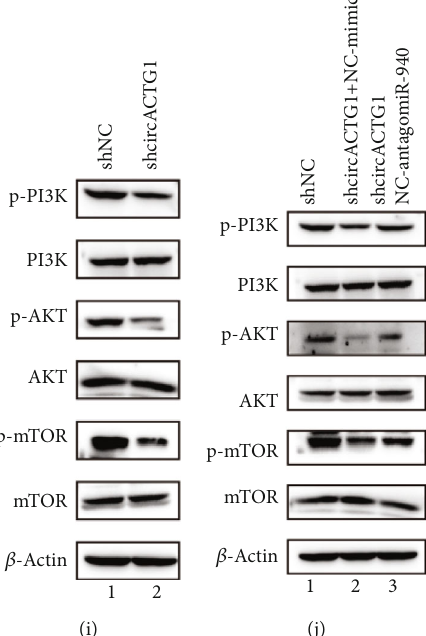
Figure 5: The AKT-mTOR pathway was activated by circACTG1/miR-940/RIF1 axis. (a and b) Expression of RIF1 after transfecting miR- 940 mimic. (c and d) Expression of RIF1 after transfecting shcircACTG1. (e and f) Expression of RIF1 with circACTG1 knockdown or combined with miR-940 inhibitor. (g) Overall survival of RIF1 expression. (h – j) AKT-mTOR pathway molecule expression after transfecting miR940 mimic (h), shcircACTG1 (i), and shcircACTG1 and miR-940 inhibitor